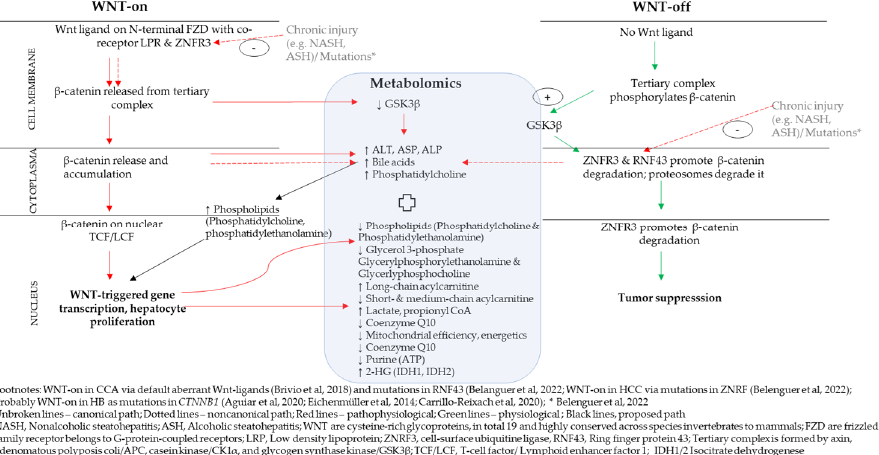
Figure 1. Integrated WNT/ β -catenin pathway and metabolomic indicators. References cited in the figure are [3,4,10,21,30].